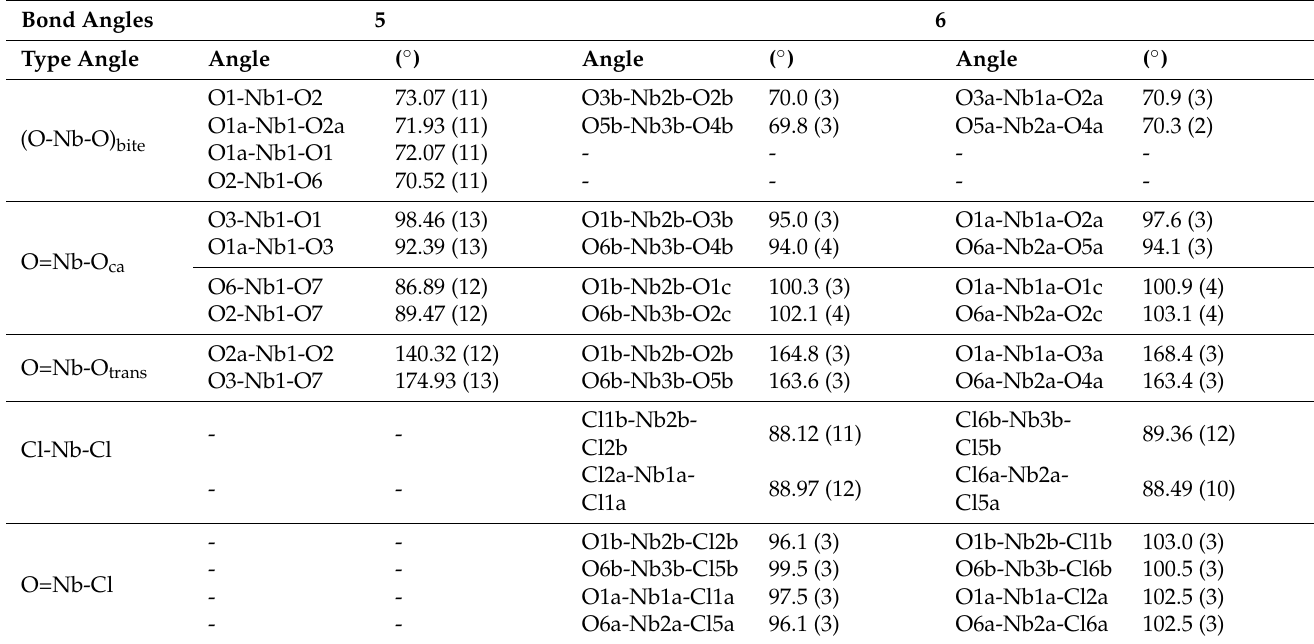
Table 4. Selected bond angles in (Et 4 N) cis -[NbO(ca) 2 (H 2 O)OPPh 3 ] · 3H 2 O · THF ( 5 ) and (Et 4 N) 4 [Nb 4 O